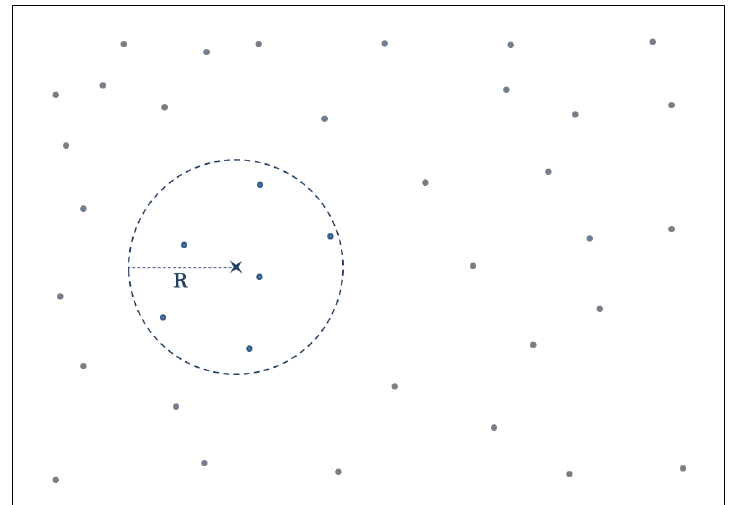
Figure 3. A demonstration of the improved IDW. The dots are the sample data points, and the x is the point location to be interpolated. R is a user-defined radius parameter that indicates the farthest distance to be included from the points x . In this case, only a total of six sample points will have an influence on the interpolation process. However, no empirical approach has been developed to obtain the optimal value for the parameter R